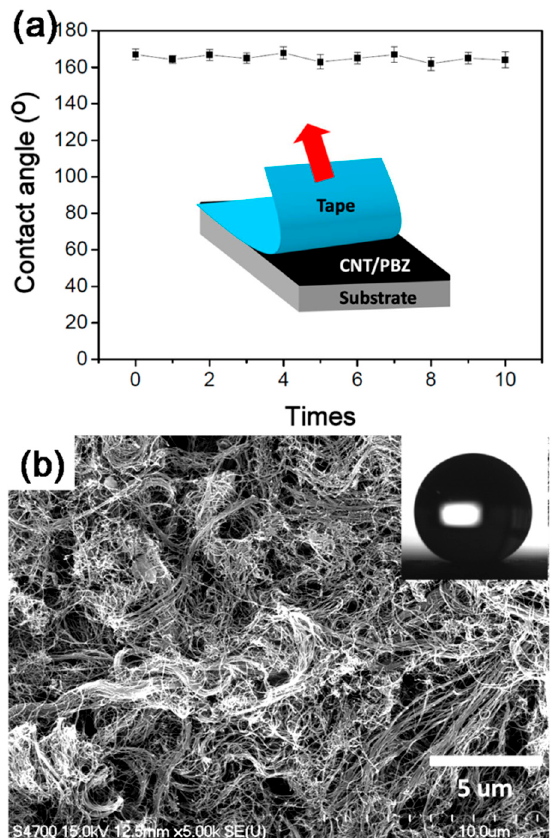
Figure 3. ( a ) Plot of the water contact angles as a function of the number of times of tape test. Inset: schematic of tape test. ( b ) SEM image of the superhydrophobic CNT/polybenzoxazine film after performing the tape test 10 times. Inset: photograph of the water droplet on the sample.